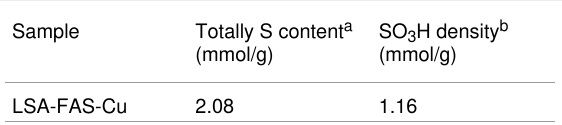
Table 3: Acid density of